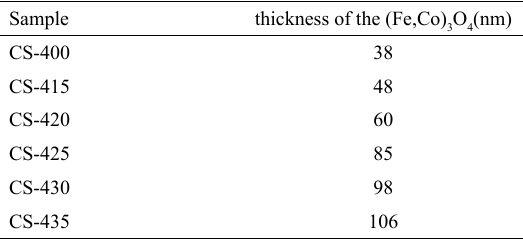
Table 3. Average thickness of the (Fe,Co)3O4 phase estimated using XRD and Rietveld refinement.